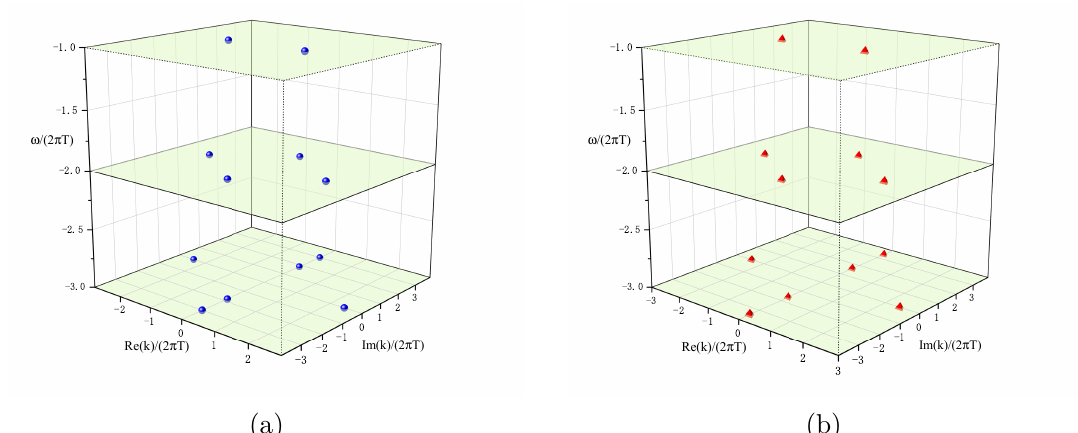
along the x -direction in x